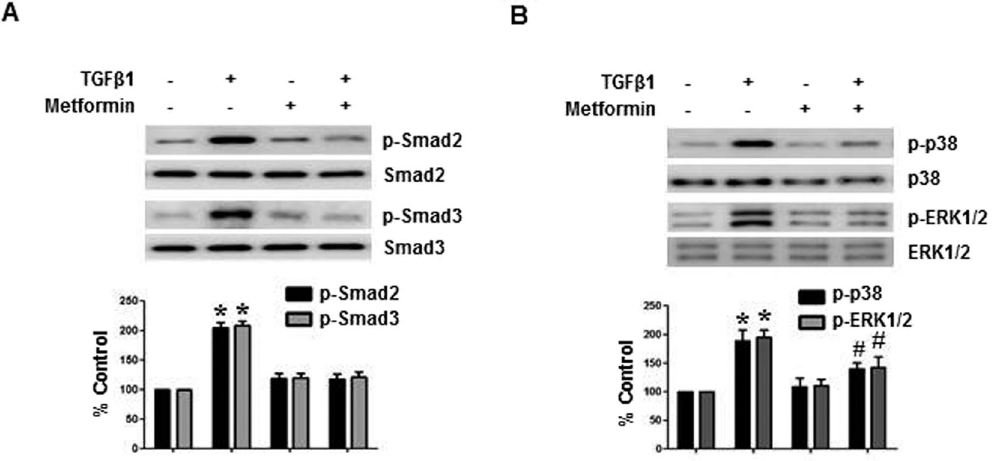
Figure 2. Effect of Metformin on TGF- β -induced Activation of Smad2/3 and MAPKinase Signaling. Metformin (1 µ M) blocks TGF- β 1-induced phosphorylation of Smad2/3 ( A , 30 minutes), p38 and ERK1/2 MAPK ( B , 3 hours). Representative western blots with quantitation bars (n = 6) are shown. * p < 0.05 vs. others, # p < 0.05 vs. TGF- β 1.